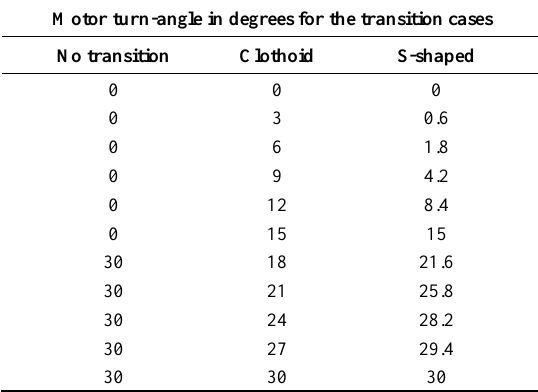
Table 1. Change in motor turn-angle to create different transitions. Discretized into 11 steps over 5.5 seconds. Motor turn-angle in degrees for the transition cases No transition Clothoid